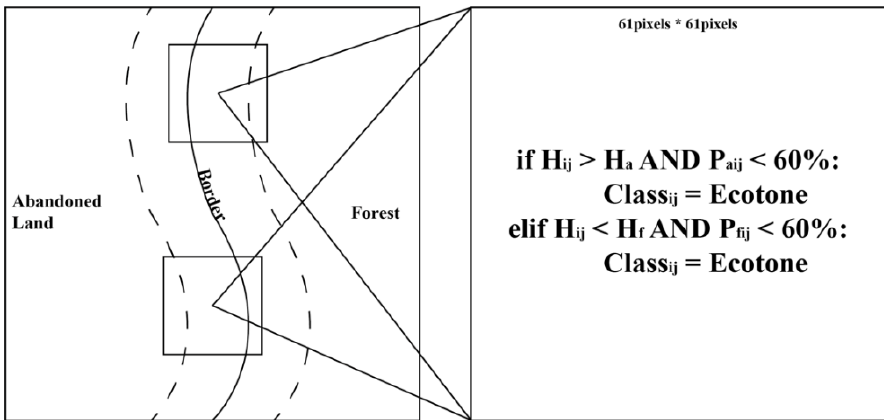
Figure 3. Shrinking process diagram. The moving window along the border between the abandoned land and the forest was used as the judgment basis for the shrinking into the interior of the forest and the interior of the abandoned land where P a denotes the proportion of pixels in the whole window of the abandoned land. Moreover, the P f denotes the proportion of pixels in the whole window of the forest. Ha and Hf denote the average height of abandoned land and forest, respectively.